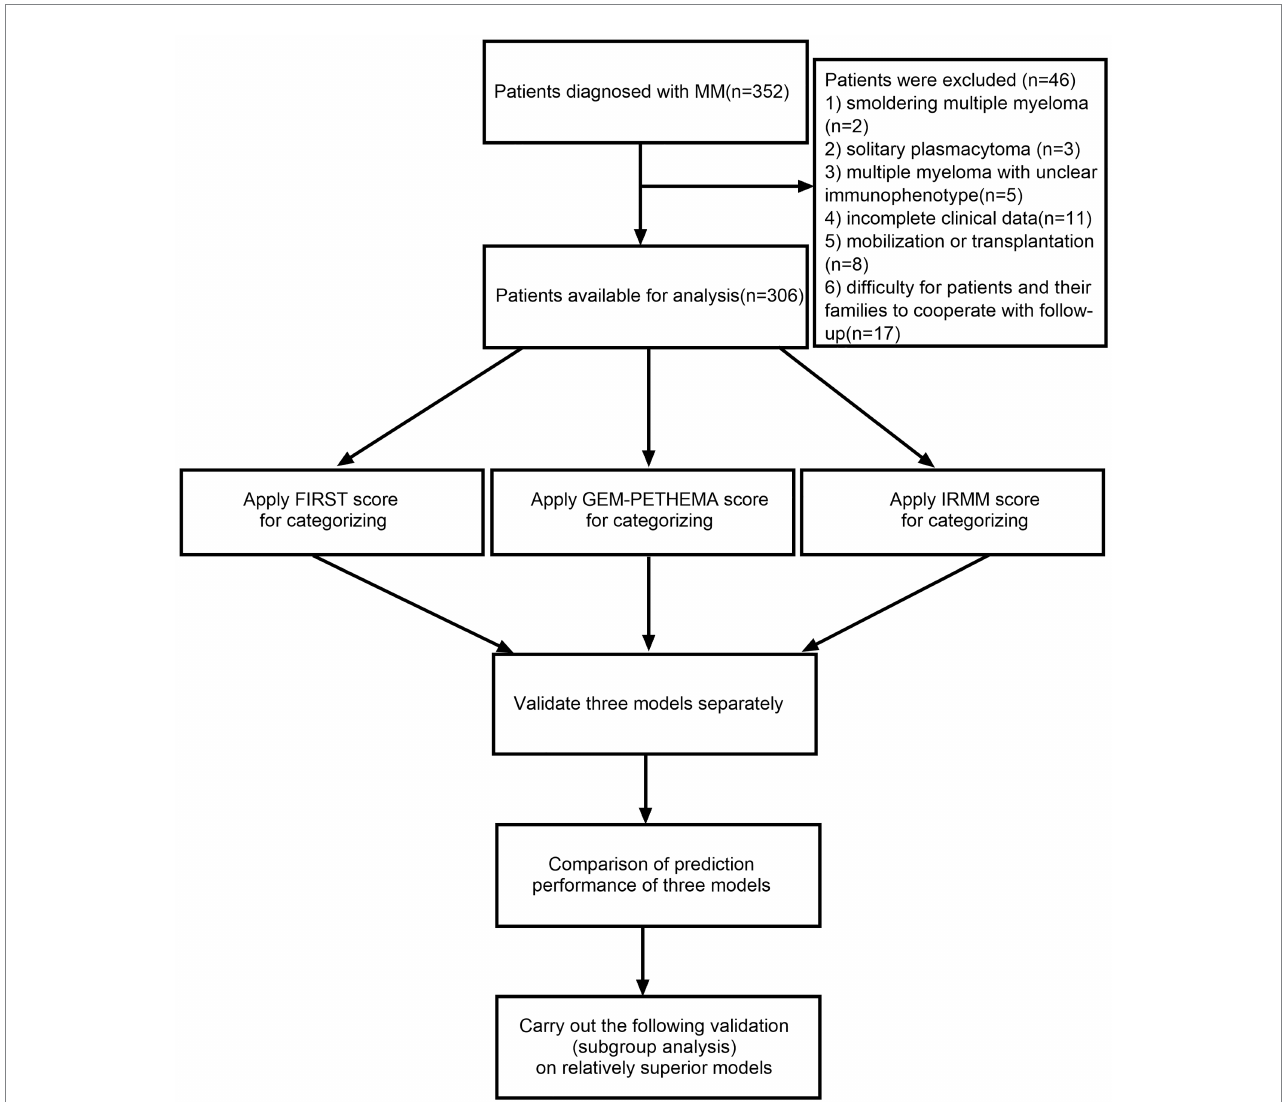
FIGURE 1 The flow diagram in this study. Using the International Myeloma Working Group (IMWG) criteria 352 patients were diagnosed with multiple myeloma (MM). The following reasons led to the exclusion of 46 patients: (1) smoldering MM ( n = 2), (2) solitary plasmacytoma ( n = 3), (3) MM with unclear immunophenotype ( n = 5), (4) incomplete clinical data ( n = 11), (5) mobilization or transplantation ( n = 8), and (6) difficulty for patients or their families to cooperate with follow-up ( n = 17). FIRST score was used for assignment and grouping: β 2-MG ≤ 3 mg/l was assigned-2 points; ECOG < 1 was assigned-1 point; hemoglobin ≤ 110 g/l, ECOG ≥ 2, LDH ≥ 200 U/l was assigned 1 point; β 2-MG ≥ 6 mg/l was assigned 2 points. We defined-3-1 point as low-risk and 2–5 points as high-risk. GEM-PETHEMA score was used for assignment and grouping: serum albumin ≤ 30 g/l, ECOG > 1, male, non-IgA MM was assigned a score of